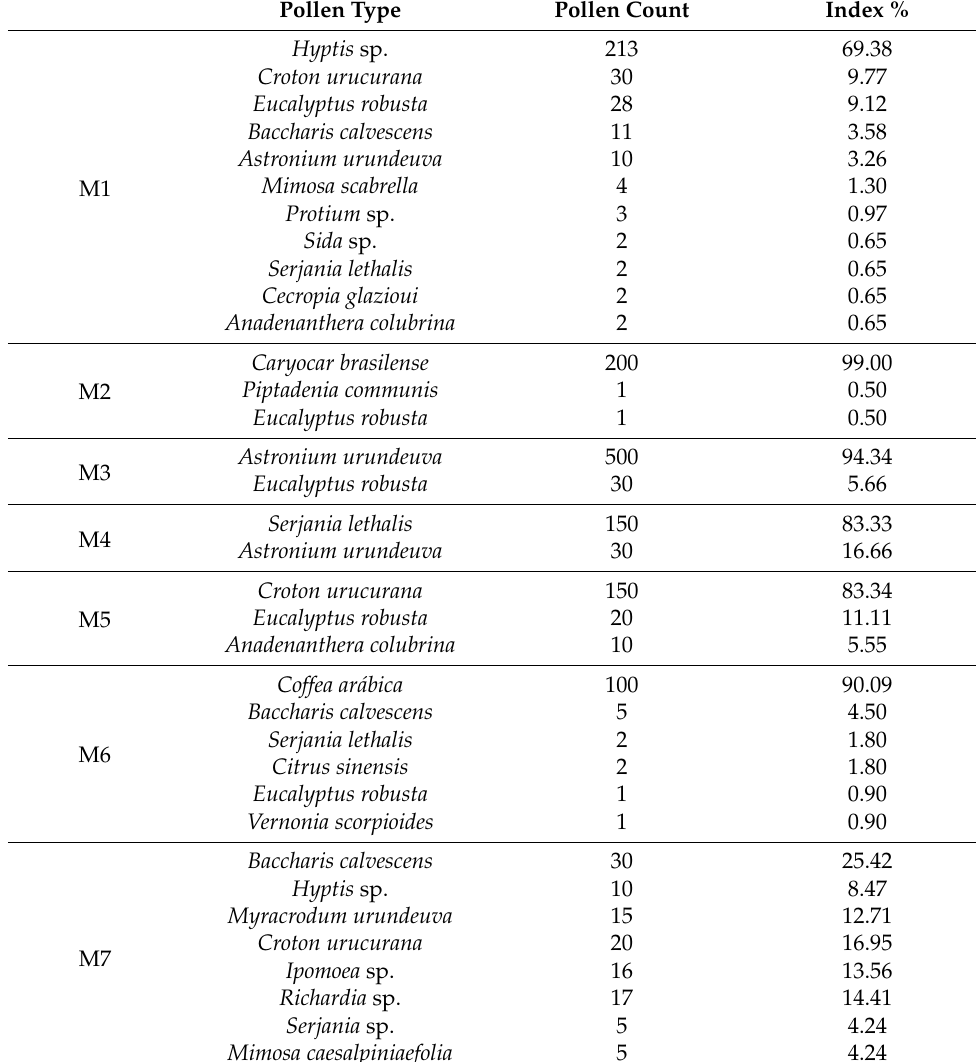
Table 1. Pollen analysis in honeys.